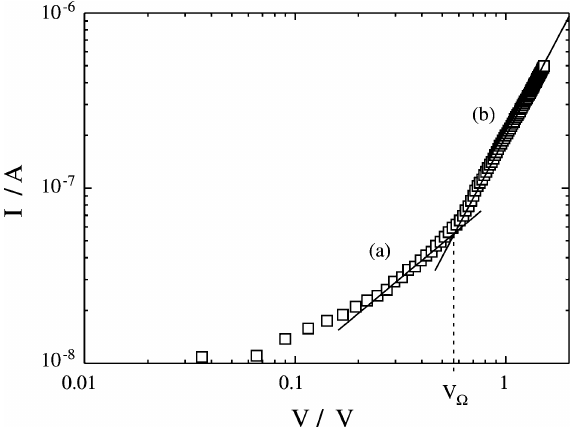
Figure 5. Dependence of µ eff on temperature. Ni/OPPVDBC/Al device; Device area: 1 mm 2 ; OPPVDBC layer thickness: 130